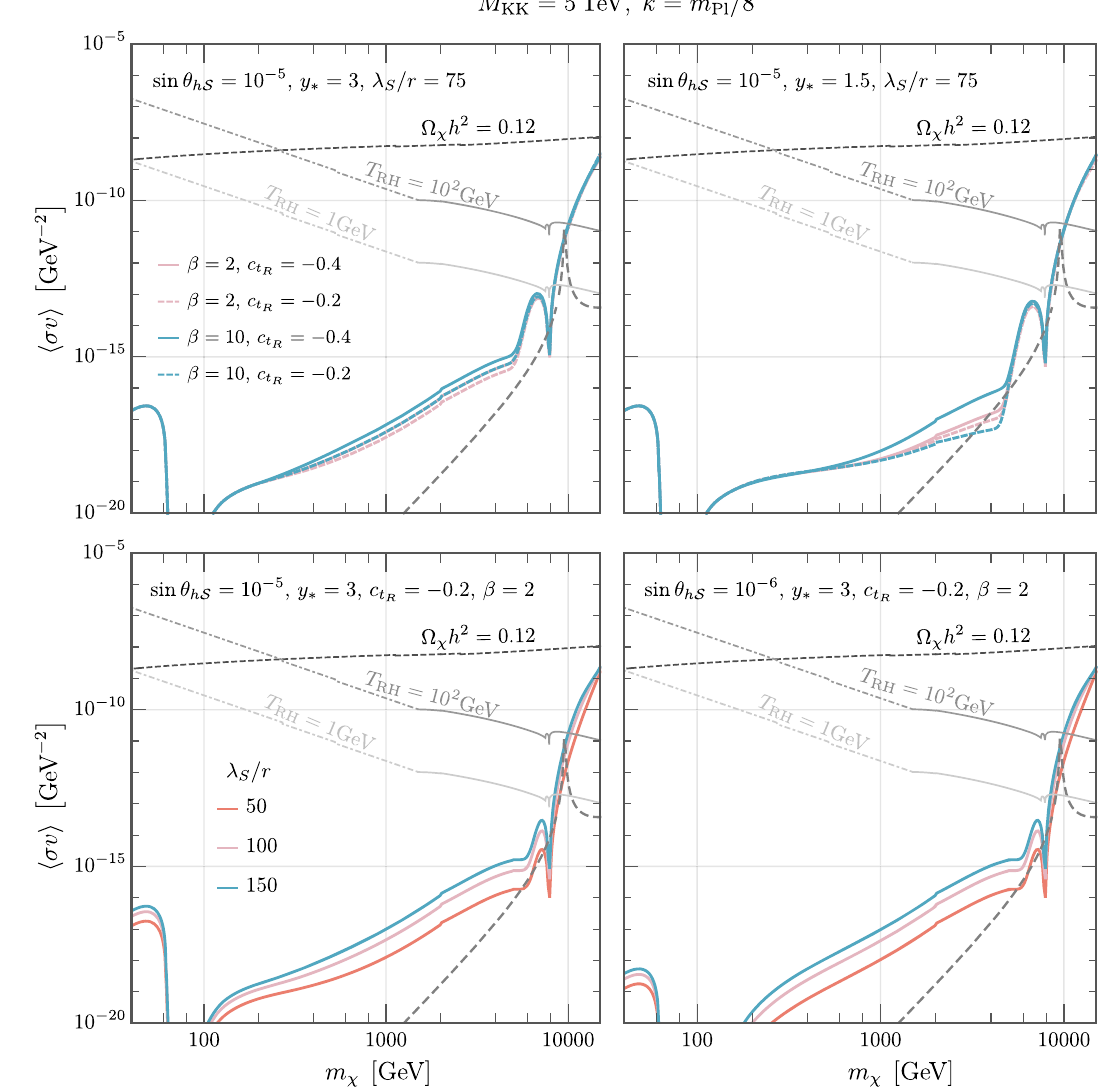
Fig. 8 Velocity-averaged annihilation cross section (cid:16) σv (cid:17) at the freeze- first KK graviton. We also show the velocity averaged cross section out temperature as a function of the DM mass m χ , for N χ = 1, reproducing the relic density experimental value from Planck in dashed M KK = 5 TeV and k = m Pl / 8. In the top panels, we fix sin θ h S and black, and the equivalent for a matter dominated freeze out in gray, for λ / r and consider two different values of y ∗ . In both cases, we take two different values of T RH , after using T (cid:25) = 10 5 GeV and τ = 0 . 99. S two different values of β and c t For these lines the section in dot-dashed gray corresponds to predic- . In the bottom panels, we fix β , y ∗ R tions for which x f < 3, and therefore in this regime the DM decouples and c t and consider different values of λ S / r for sin θ h S = 10 − 5 (left) R and sin θ h S = 10 − 6 (right). In all four panels, we also show in dashed relativistically gray the (cid:16) σv (cid:17) prediction for diagrams mediated by the exchange of the